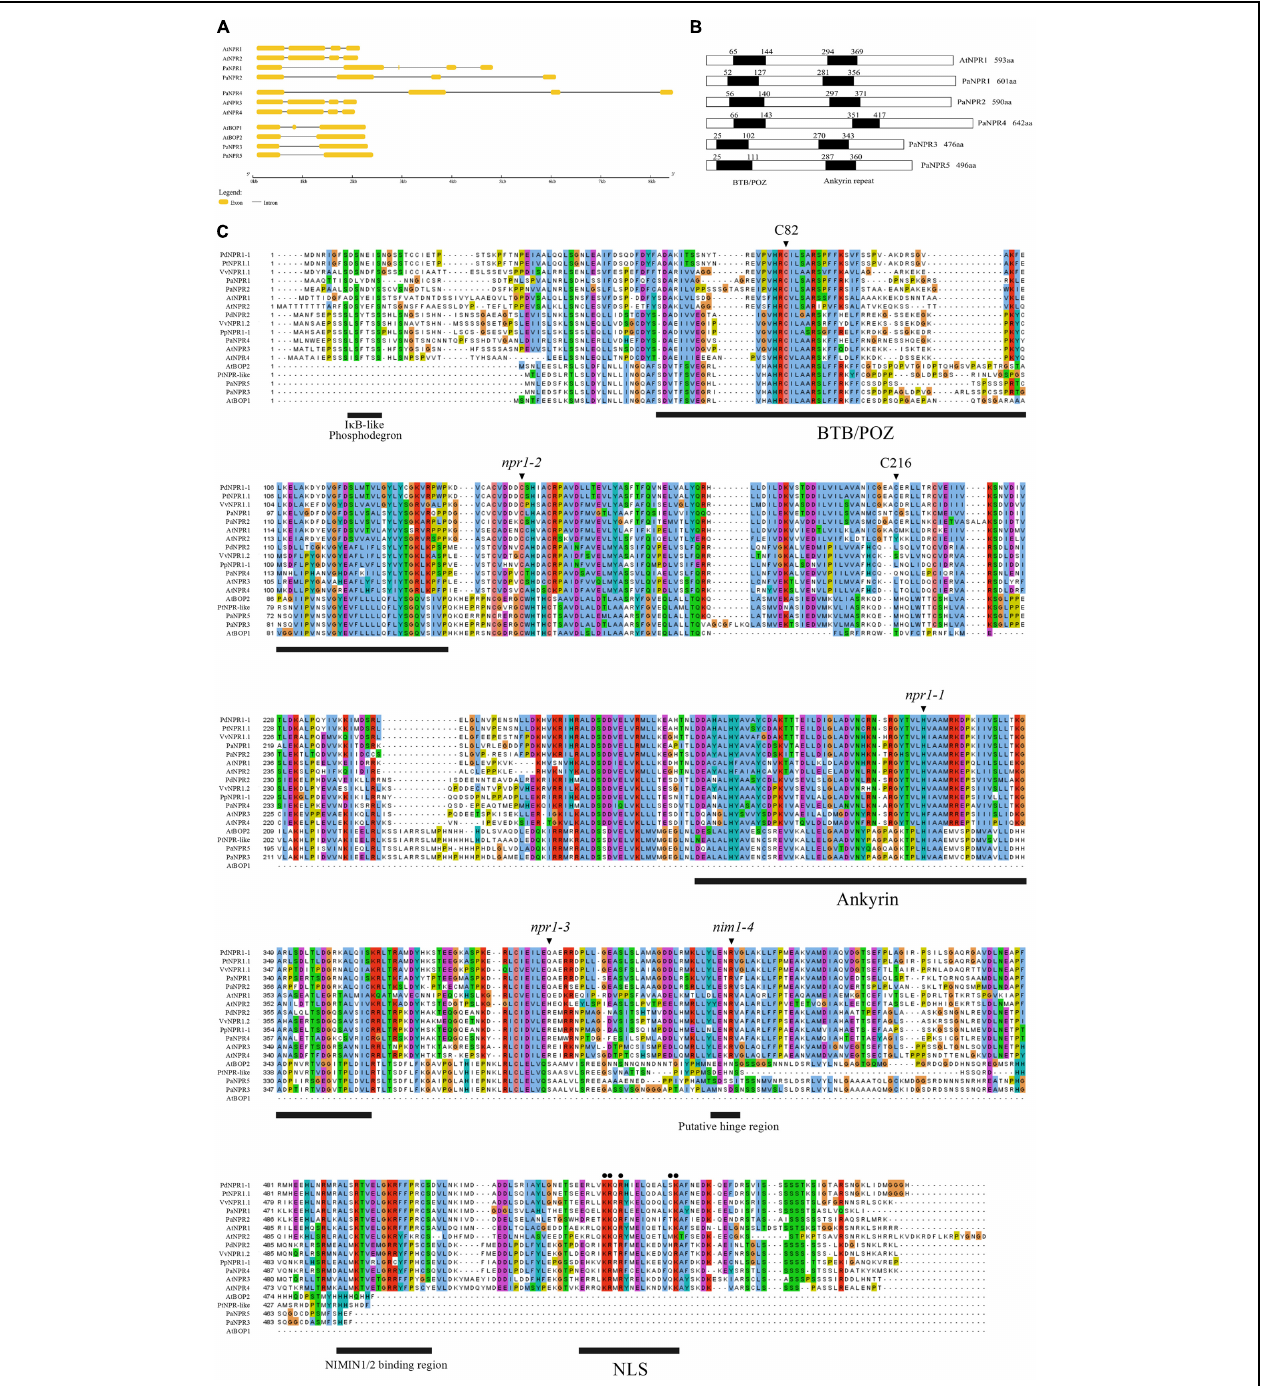
FIGURE 1 | Exon/intron boundary and predicted coding sequence comparison of PaNPR1 -like genes with other known NPR1 -like sequences. (A) The predicted exon/intron structure of the NPR1 -like family from Arabidopsis thaliana and Persea americana . Exons are denoted by yellow boxes while introns are represented by thin black lines. (B) A comparison of the positions of the BTB/POZ and ankyrin repeat domains between the PaNPR1-like and AtNPR1-like family of proteins. (C) A multiple alignment of PaNPR1-like proteins and several other known NPR1-like proteins from woody plants and Arabidopsis . The